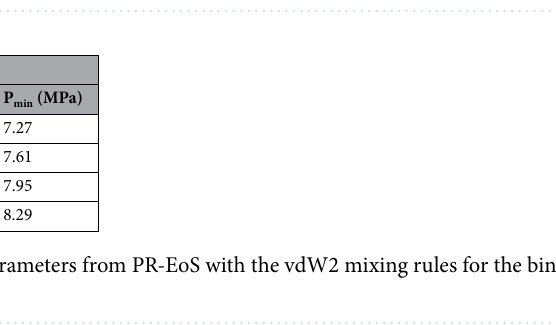
Figure 4. Relative molar volume change of the liquid phase vs. pressure, for the binary system (CO 2 –DMSO) at various temperatures (308, 318, 328 and 338 K).